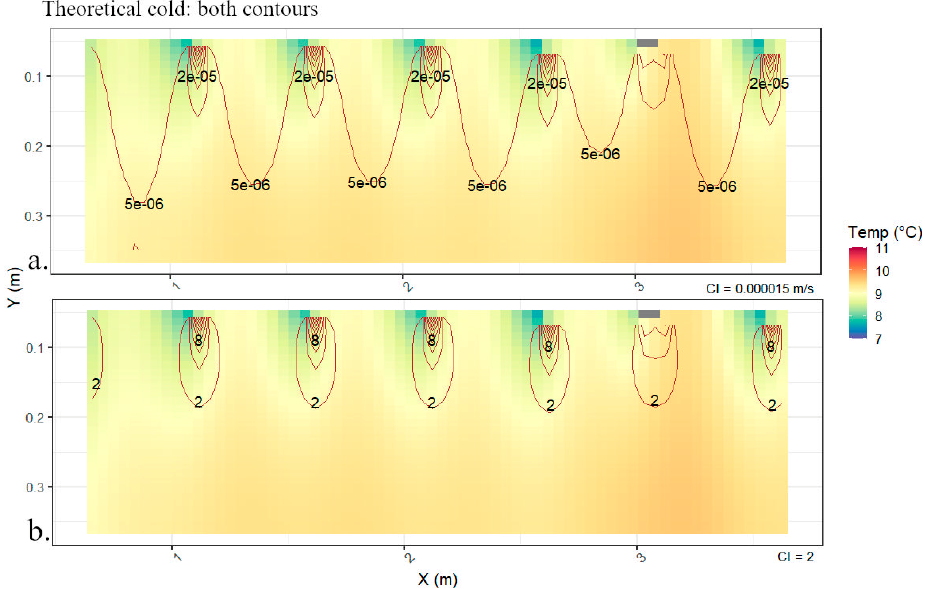
Figure 4. Temperature heatmaps of the theoretical cold trial with a starting ambient temperature of 10 degrees Celsius and input temperature of 5 degrees Celsius ran for 60,000 s. ( a ) is overlain with contours of horizontal Darcy flux (CI = 0.000015 m/s). ( b ) is overlain with contours of Pe number (CI = 2). Additionally, the shape of the contours is driven by the modeling software’s ‘step-down’ type gradient, and the actual contours would be more laterally continuous (see Section 4.1).